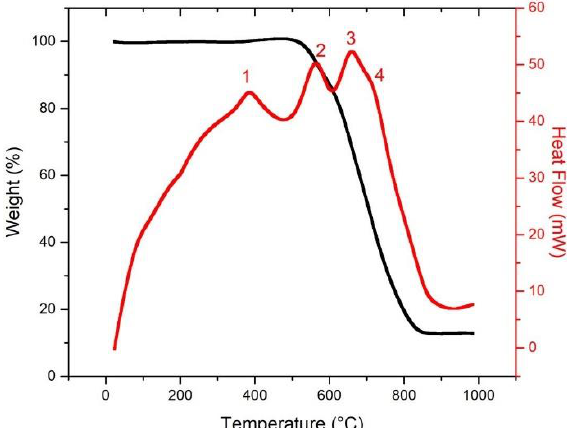
Figure 10. Thermogravimetry of Nanocomp YE-A10 CNT fiber with weight loss (%) and heat flow (mW) reported. There are four exotherms of interest here, which cater to compositional changes in the fiber and can explain the effect of fiber annealing better.